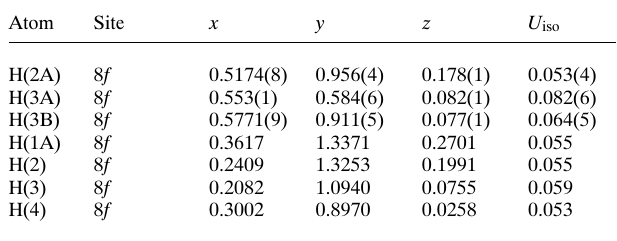
Table 2. Atomic coordinates and displacement parameters (in Å 2 )